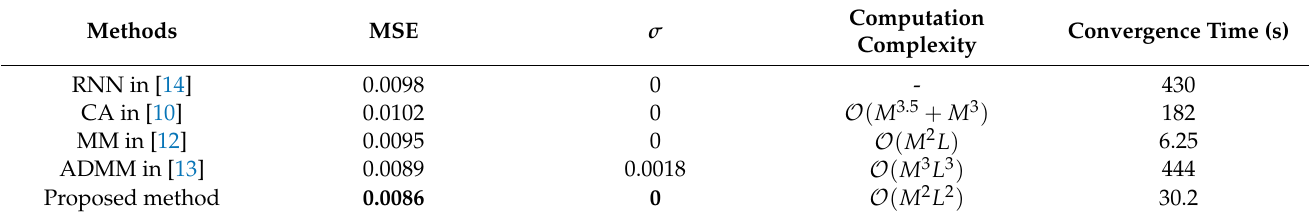
Table 1. The MSE, σ , computation complexity, and convergence time (seconds) for different methods when considering Case 1 as the desired